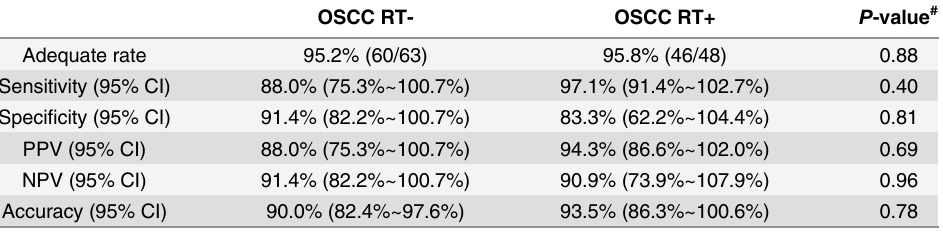
Table 2. A comparison of the diagnostic efficacy of USgFNA in treated OSCC patients without previ- ous neck RT (RT-) and those with prior neck irradiation (RT+).